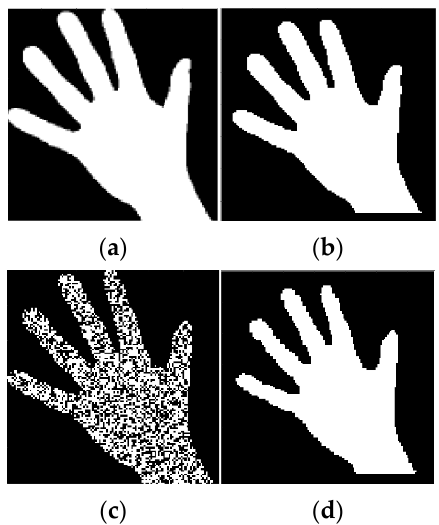
Figure 5. Results of reconstruction of a hand-mask image based on qualitative data. ( a ) Original image; ( b ) Reconstructed image; ( c ) Original strong noisy image; ( d ) Reconstructed noisy image.